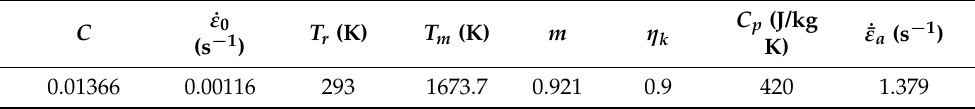
Table 2. Parameters associated with the rate- and temperature-dependent plasticity model.